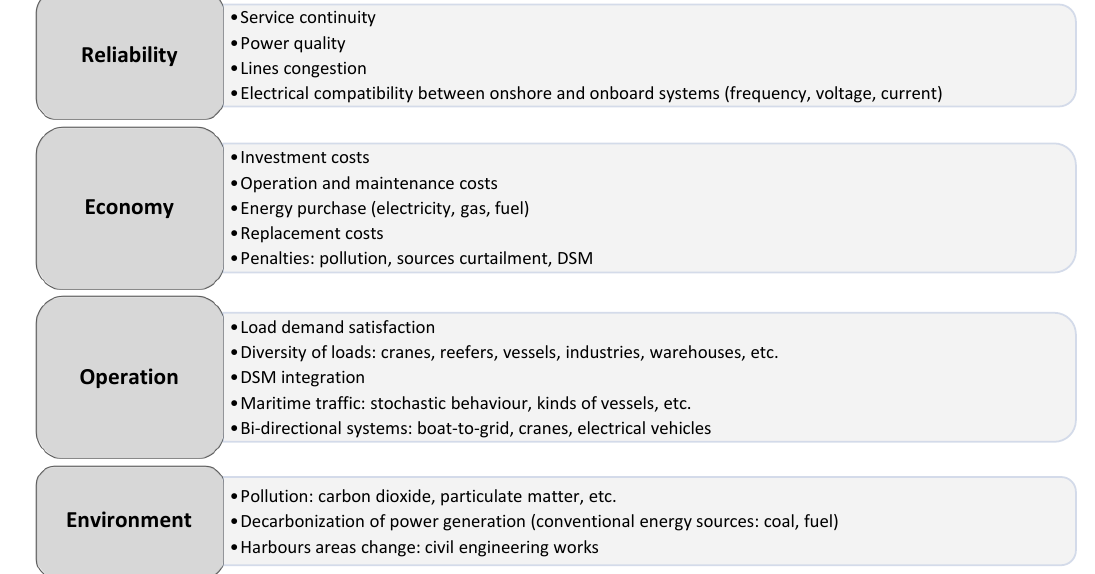
Figure 3. Summary of the aspects needing to be considered for the design, sizing, and energy management of harbor microgrids.